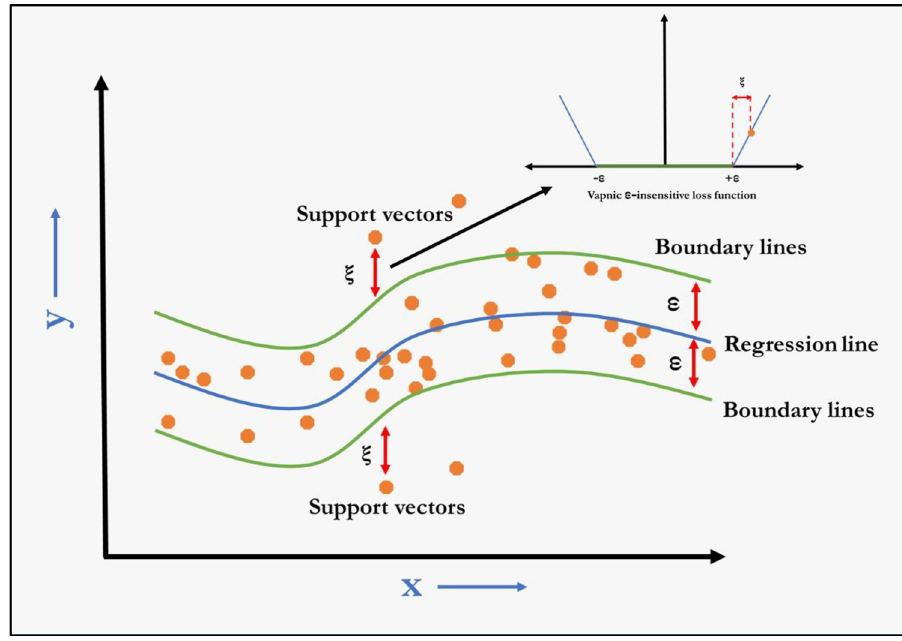
Fig 2. The algorithm of